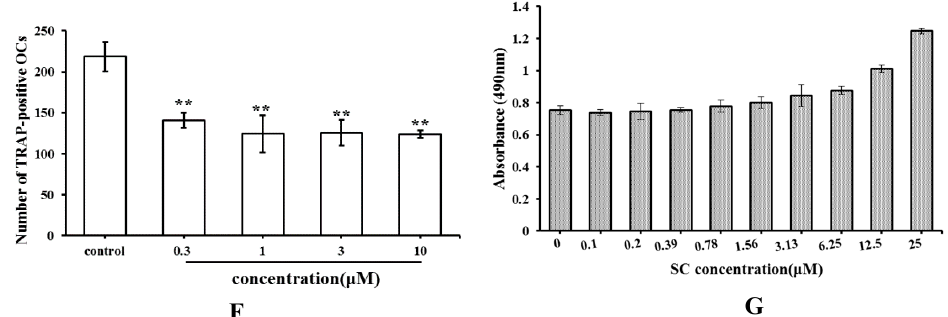
Figure 4. Effect of SC treatment on osteoclast formation (** p < 0.01 compared with the control group). ( A – E ) TRAP staining images ( × 100). ( F ) The number of TRAP-positive multinucleated OCs. ( G ) Cell viability assay.